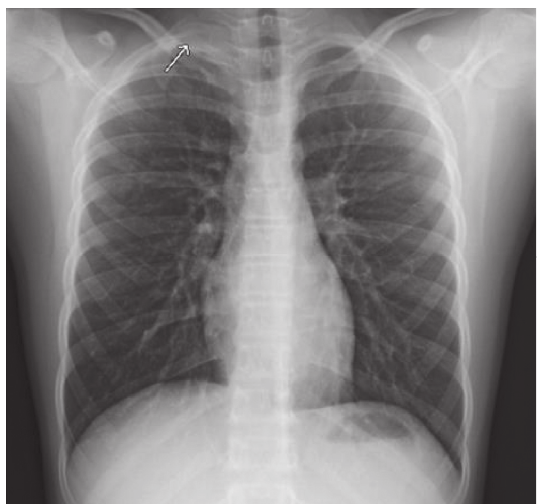
Figure 1: Chest radiograph showing a rounded density (32 mm × 22mm) at the right lung apex.